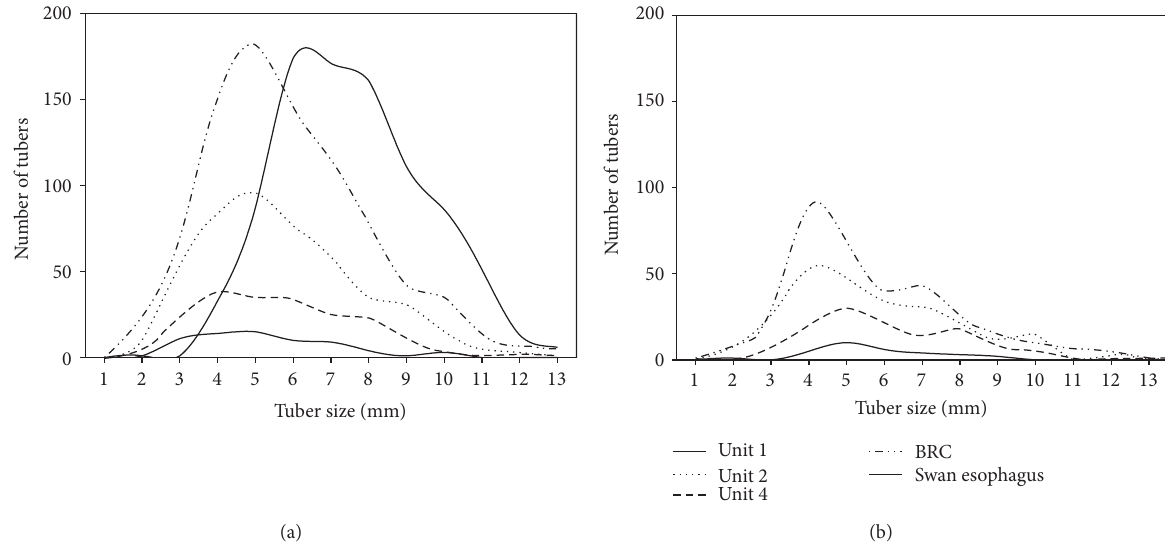
Figure 3: Number of tubers for each tuber length (mm) in a representative swan esophagus (a) and collected from sediment cores of the four studied wetlands in September (a) and March (b). Note that absolute number of tubers is presented to show differences in tuber density among wetlands and seasons. Mean ± 1SE of tuber length for swans: 7.57 ± 0.64 mm, Unit 1: 5.57 ± 0.22 mm, Unit 2: 6.14 ± 0.13 mm, Unit 4: 6.06 ± 0.14 mm, BRC: 6.25 ± 0.07